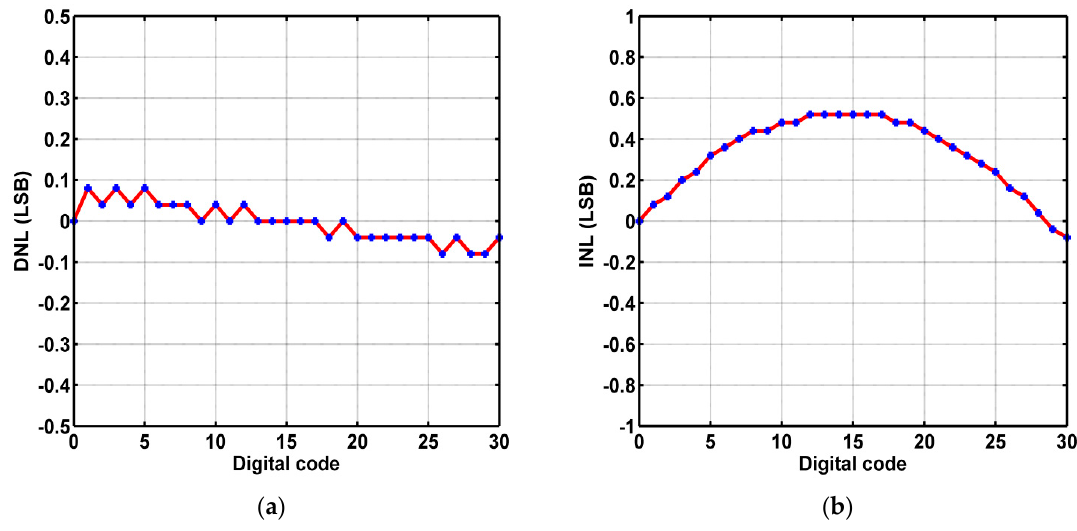
Figure 28. ( a ) DNL for the second proposed ADC, and ( b ) INL for the second proposed ADC.